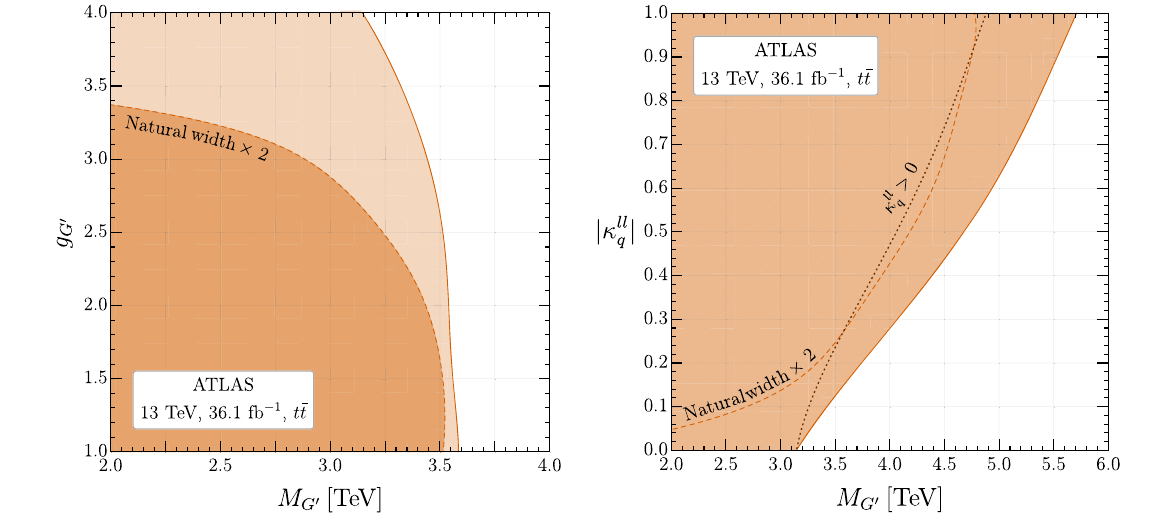
Fig. 9 Left: Exclusion plot for the pp → t ¯ t search in the ( g G (cid:2) , M G (cid:2) ) plane for the natural width (solid line) and twice the natural width (dashed line). Right: Exclusion limits on the coupling to light left- handed quarks κ ll q . The regions bounded by solid and dashed lines